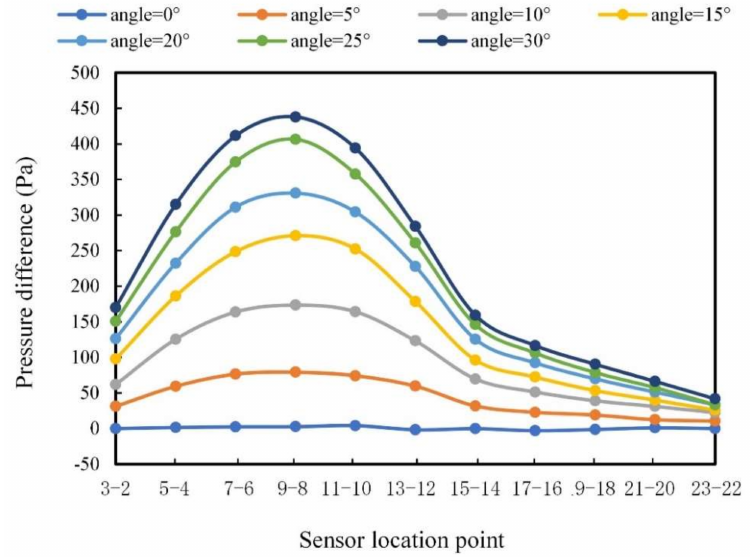
Figure 20. Pressure di ff erence